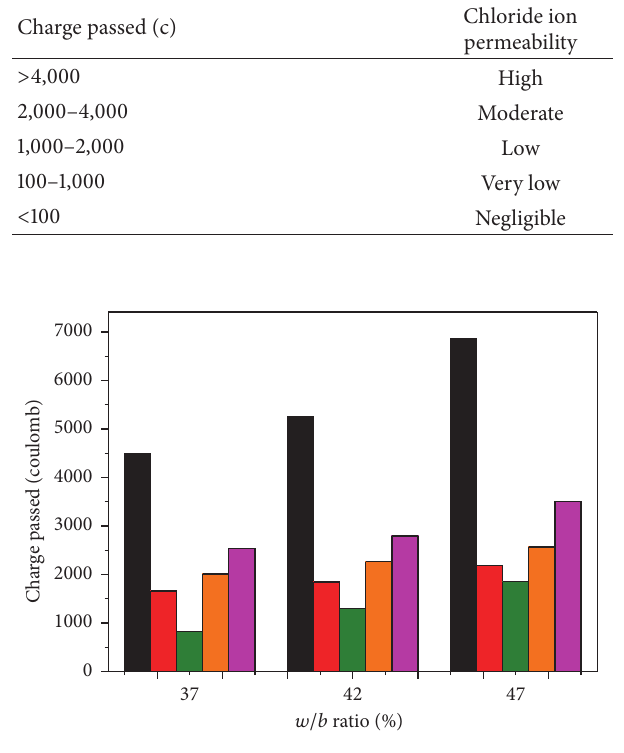
Figure 3: RCPT results of HPC with GGBFS and FA.